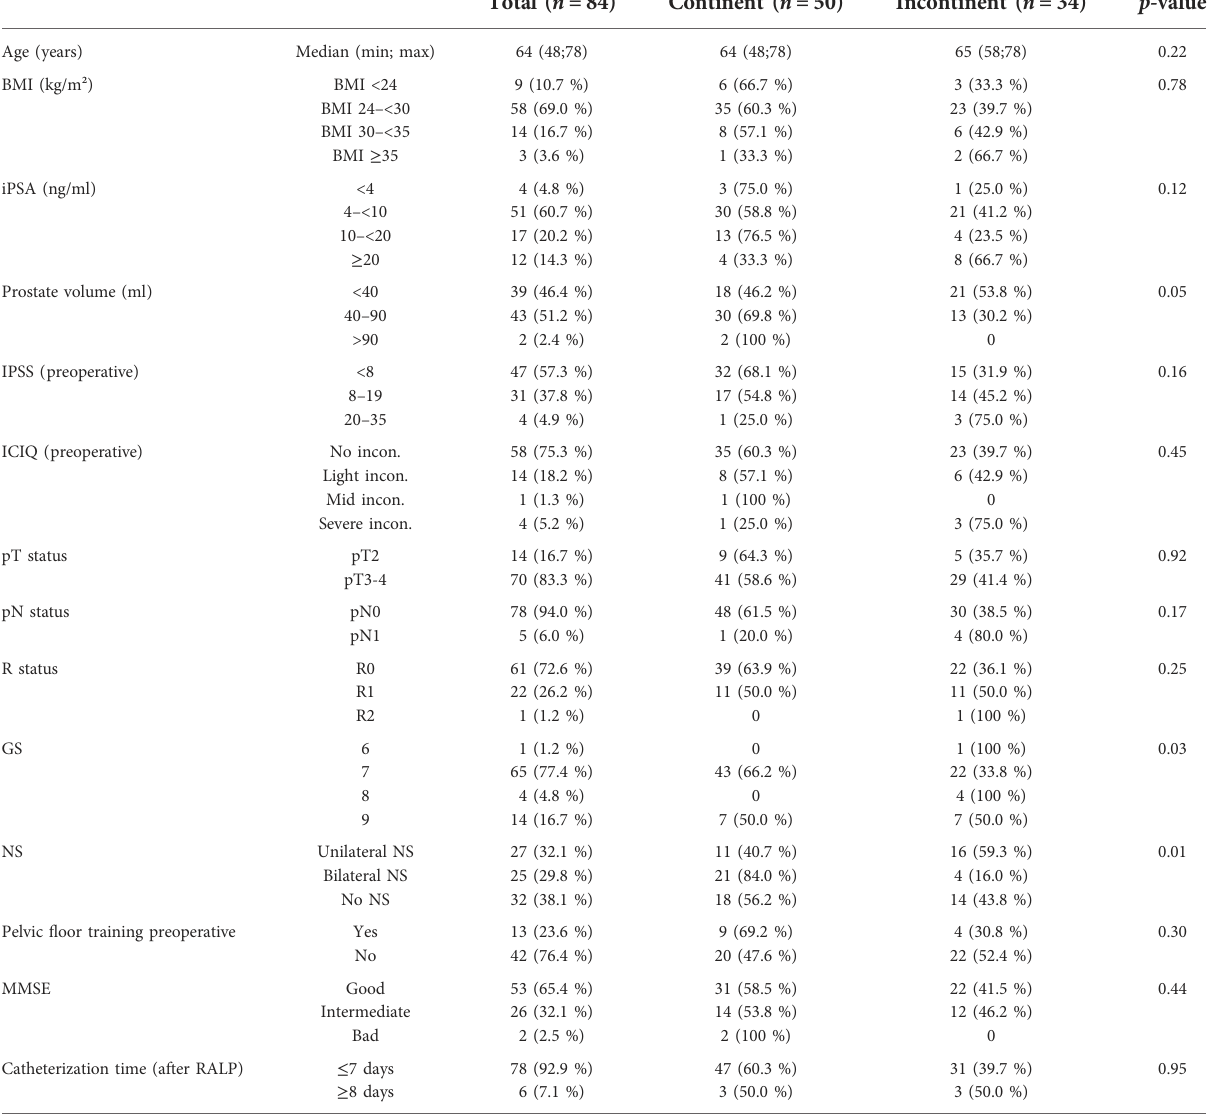
TABLE 2 Patient characteristics between the “ continent ” and the “ incontinent ”